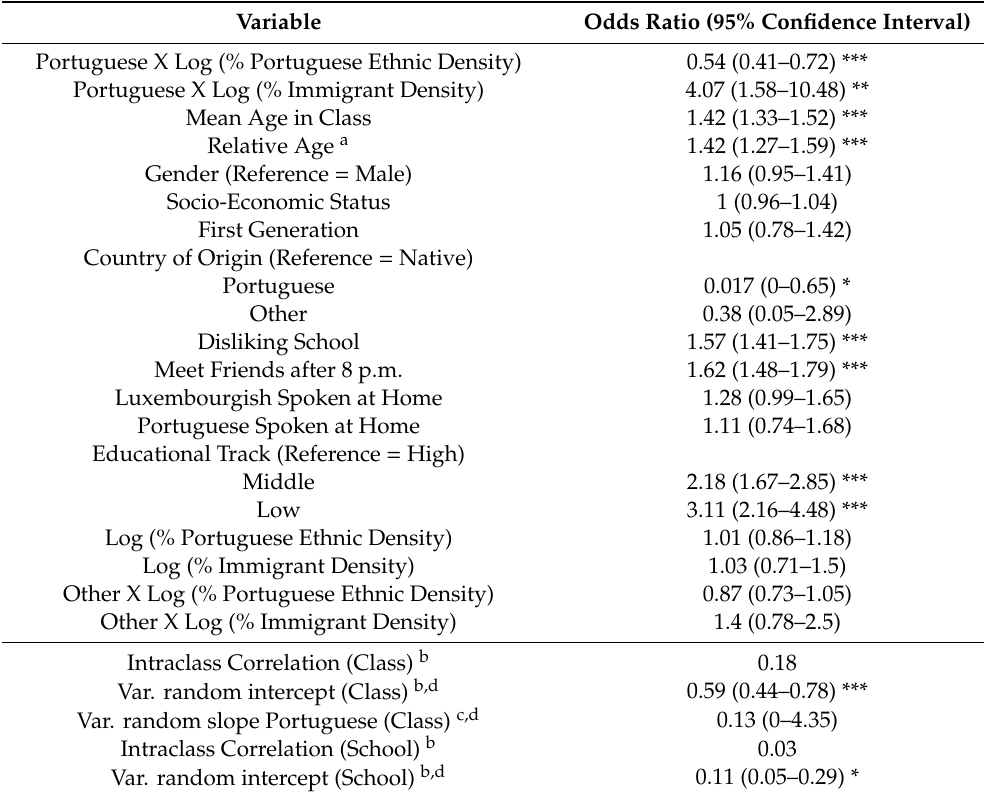
Table 2. Analyses for the whole sample: Interaction between being of Portuguese descent and co-ethnic and immigrant